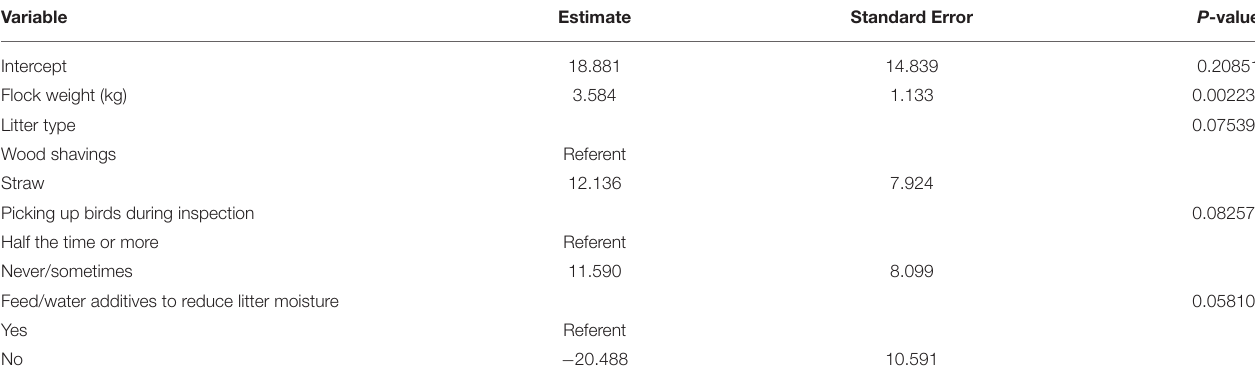
TABLE 5 | Final multivariate linear regression model for FPD prevalence in turkey flocks in Canada (alpha = 0.05, adjusted R 2 = 0.2148, p = 0.003347, N Flock =